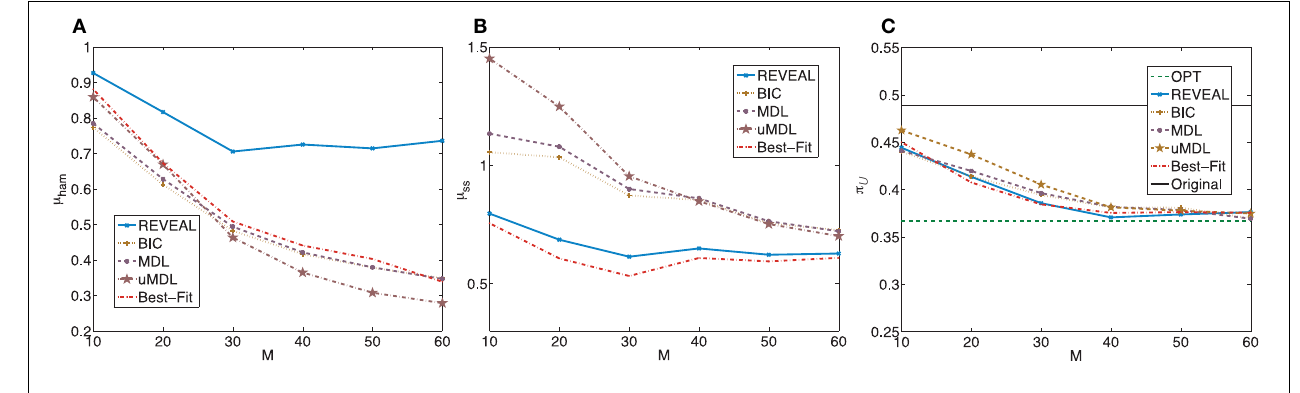
FIGURE 4 | Performance comparison of five network inference algorithms by different average validity indices based on BNps with 9 genes and K = 3. (A) Average normalized Hamming distance μ ham ; (B) μ ss ; (C) average undesirable steady-state mass π U after applying derived